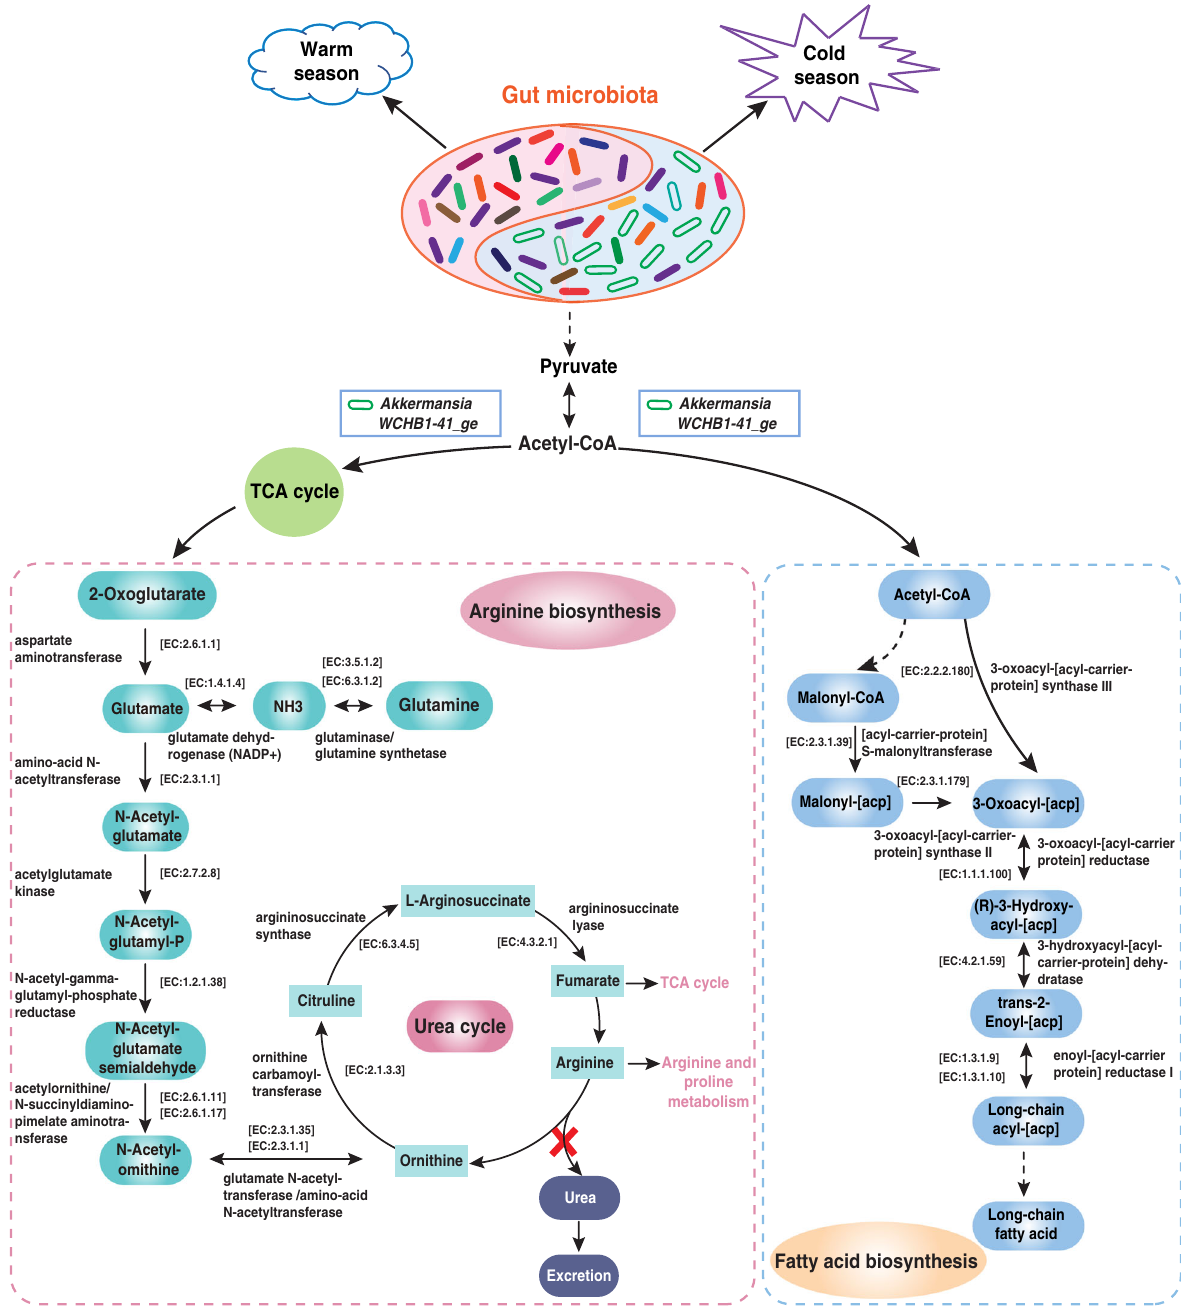
Fig. 8 Metabolic pathway associated with Akkermansis and uncultured Eubacterium WCHB1-41_ge on host metabolism. The compositions of Akkermansis and uncultured Eubacterium WCHB1-41_ge are the key factors that in fl uence arginine biosynthesis and fatty acid biosynthesis and were signi fi cantly higher during the cold season. These microbiota may contribute to energy production during cold season, which is the period of insuf fi cient dietary and protein intake. All enzymes and EC (Enzyme Nomenclature) numbers were obtained from Kyoto Encyclopedia of Genes and Genomes (KEGG)